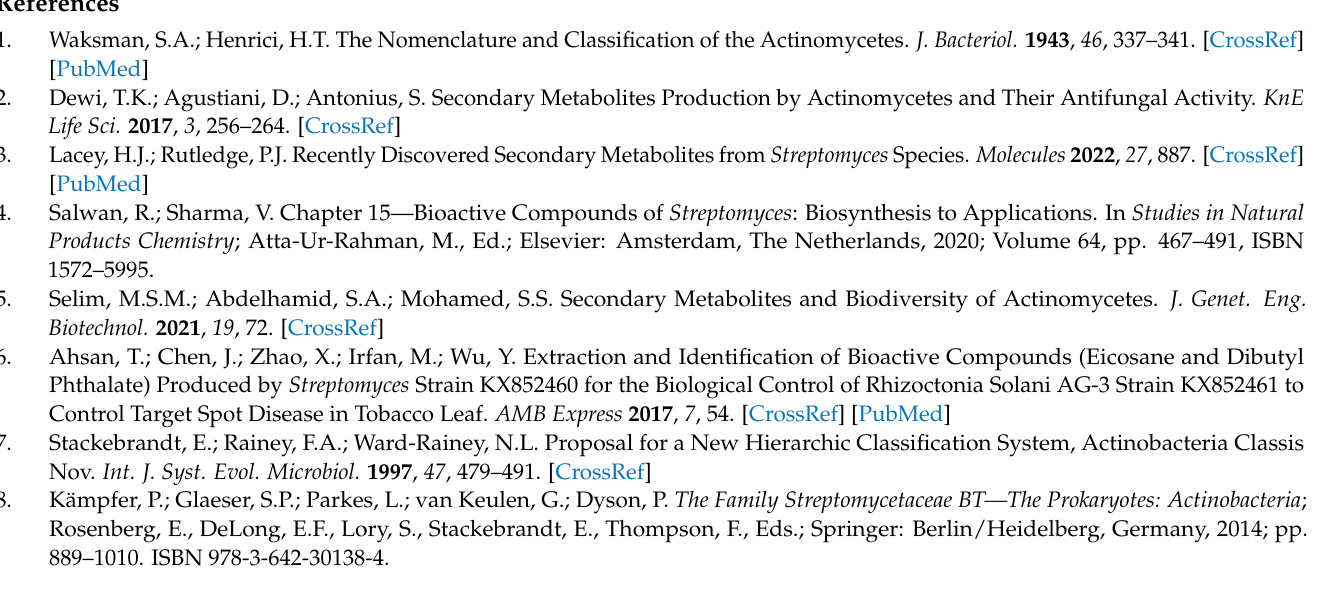
Figure S4: Non-ribosomal peptide synthetase cluster (NRPS), KnownClus- terBlast, and ClusterBlast. Figure S5: NRPS-like fragment/transAT-PKS-like, KnownClusterBlast, and ClusterBlast. Figure S6: Type II PKS BCG based on KnownClusterBlast and Pfam domains. Figure S7: Ribosomally synthesised and post-translationally modified peptide product (RiPP) clus- ter/lanthipeptide, KnownClusterBlast. Figure S8: Butyrolactone cluster, KnownClusterBlast. Figure S9: Other, cluster containing a secondary metabolite-related protein that does not fit into any other category (actinomycin D),